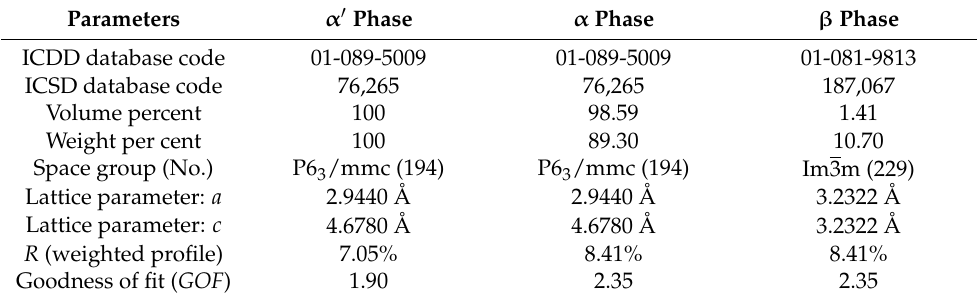
Table 5. Parameters for the Rietveld refinement of XRD patterns from the ASR ( α (cid:48) phase) and HIP ( α + β phases) Ti-6Al-4V ELI alloy samples.